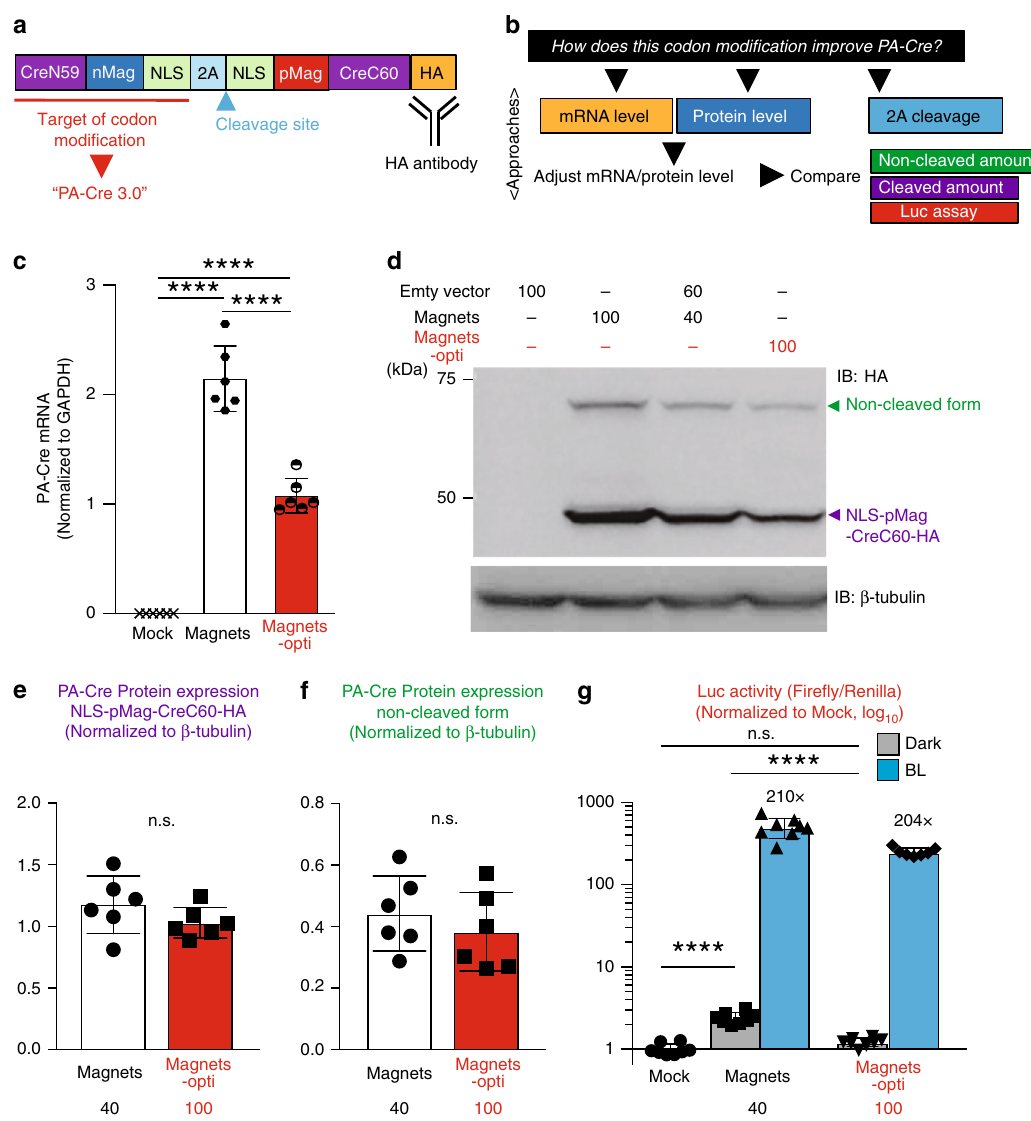
Fig. 3 Codon modi fi cation alters mRNA and protein expression and reduces dark leak in PA-Cre. a Schematic representation of PA-Cre construct fused with HA-tag. HA-tag was inserted into the carboxyl-terminus of PA-Cre construct. Codons of CreN59-nMag-NLS component were modi fi ed in PA-Cre 3.0 (Magnets-opti). b Experimental Schematic to elucidate the mechanisms underlying PA-Cre 3.0 improvement in dark leak with codon modi fi cation. First, we quanti fi ed mRNA expression level of Magnets and Magnets-opti. Second, we measured the protein expression level. In accordance with these results, we modi fi ed transfection amount to adjust PA-Cre protein expression levels in Magnets and Magnets-opti and compared the loxP recombination ef fi ciency using luciferase assay. c Quanti fi cation of CAG-driven PA-Cre transcripts in HEK 293T cells transfected with same amount of Mock (empty vector), Magnets-HA and Magnets-opti-HA plasmids using quantitative RT-PCR (**** P < 0.0001; one-way ANOVA with multiple comparison, n = 6 biologically independent samples, mean ± s.d.). d Representative western blotting images of Magnets- and Magnets-opti-transfected HEK 293T cells. CAG-driven HA- tagged PA-Cre proteins were detected by using anti-HA antibody. Loading schematics showed transfection DNA amounts of PA-Cre plasmids. Empty vector was used to adjust total amount of transfection for the cells. Protein expression of Magnets was adjusted to Magnets-opti expression, modifying Magnets plasmid DNA amount in a series of transfections (Fig. S6b). Top bands (~75 kDa), non-cleaved form of PA-Cre; bottom bands, cleaved carboxyl- terminal portion of PA-Cre construct (NLS-pMag-CreC60-HA). β -tubulin was examined as an internal control in the cells ( n = 2 biologically independent experiments). e Quanti fi cation of protein expression of cleaved component of PA-Cre, NLS-pMag-CreC60-HA. (n.s. not signi fi cant, Magnets 40 v.s. Magnets-opti 100; Two-tailed t test, n = 6 biologically independent samples, mean ± s.d.). f Quanti fi cation of protein expression of non-cleaved PA-Cre form. (n.s. not signi fi cant, Magnets 40 v.s. Magnets-opti 100; Two-tailed t test, n = 6 biologically independent samples, mean ± s.d.). g Comparison of PA- Cre activities between Magnets and Magnets-opti using the same protein expression amounts. Luc assays were conducted with double- fl oxed inverted Fluc reporter in HEK 293T cells. Transfected cells were kept in the dark or under blue light (blue LED, 447.5 nm, 8.28 W/m 2 , repeated 20 s light and 60 s dark for 12 h). The black numbers show fold-induction value (n.s. not signi fi cant, **** P < 0.0001; one-way ANOVA with multiple comparison among Mock, Magnets dark, and Magnets-opti dark, n = 8 biologically independent samples, mean ± s.d.). Source data are provided as a Source Data